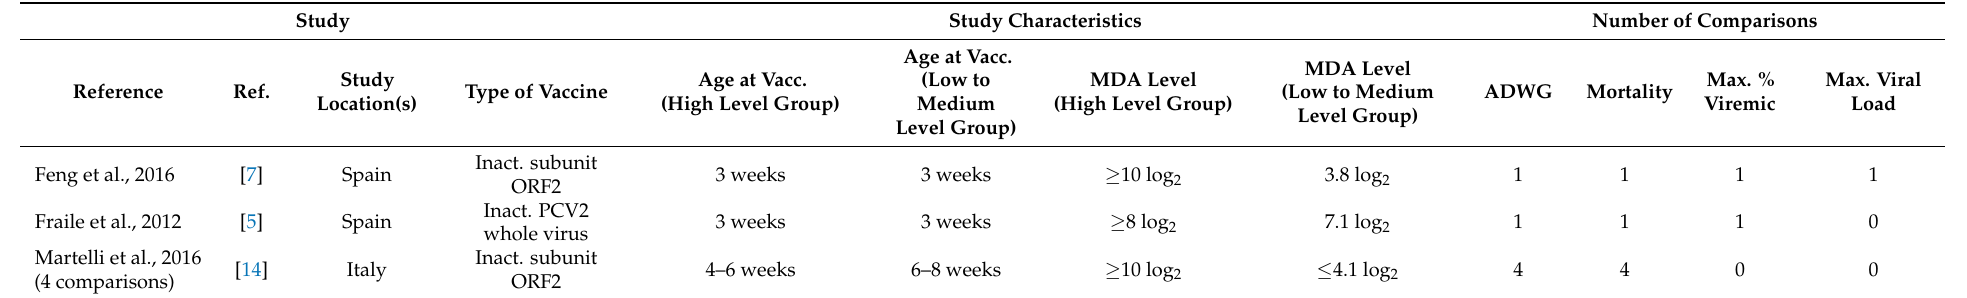
Table 2. Characteristics of the subgroup of studies additional to the group of pigs vaccinated against PCV2 in the presence of high levels of MDA ( ≥ 8 log 2 IPMA antibodies) which also reported a subgroup of pigs with low to medium levels of MDA (<8 log 2 IPMA antibodies) at the age of